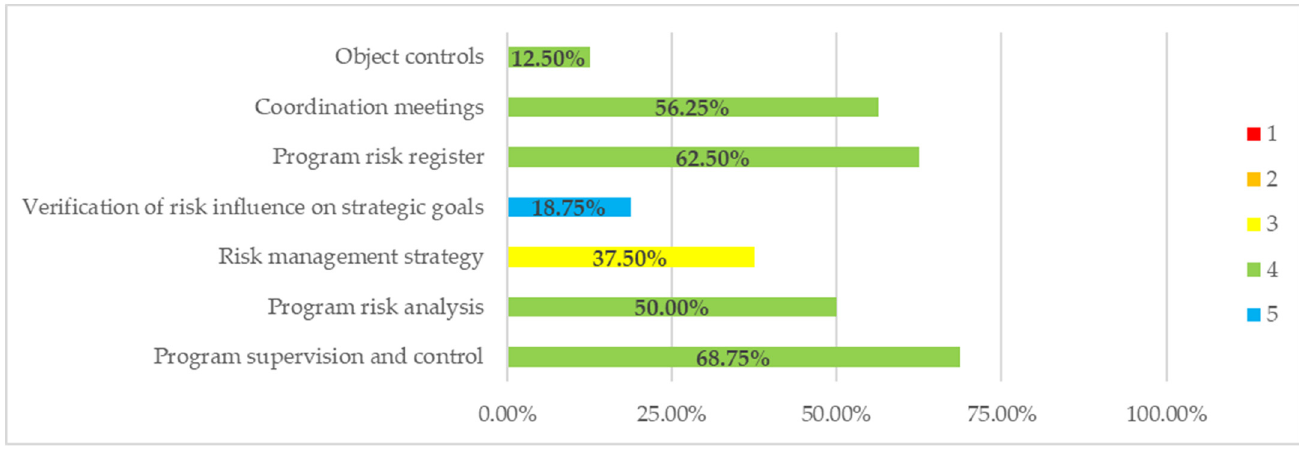
Figure 5. Evaluation of the effectiveness of the methods, techniques and tools used for the risk control process. Source: own elab.